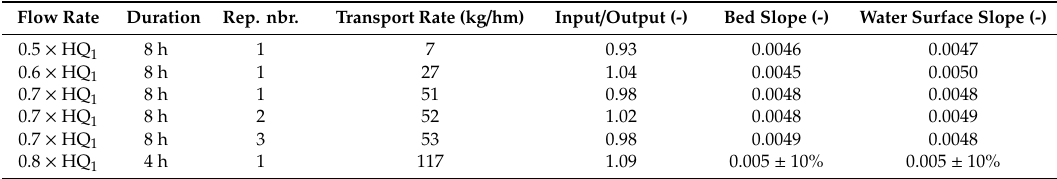
Table 3. Transport rates, ratio of fed sediment (input) vs. transported sediment (output), bed and water surface slopes at dynamic equilibrium for the investigated flow rates. Flow Rate Duration Rep. nbr.